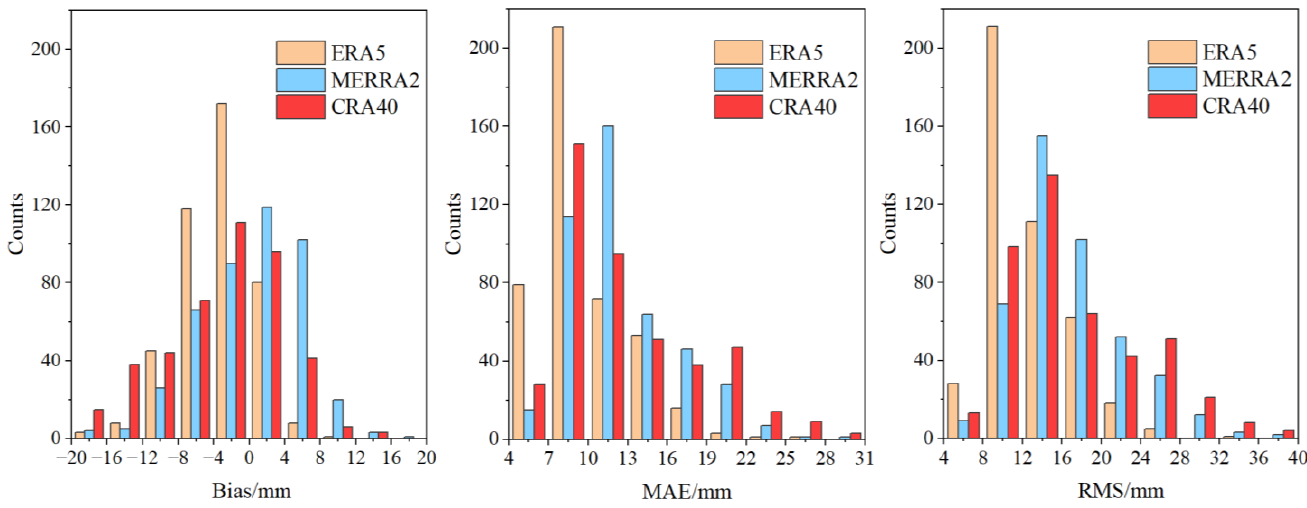
Figure 8. Station counts in different error (i.e., ZTD bias, MAE, and RMS) zones.